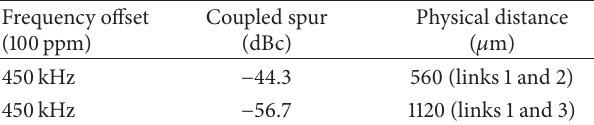
Table 1: Effect of spacing on the coupling between two active